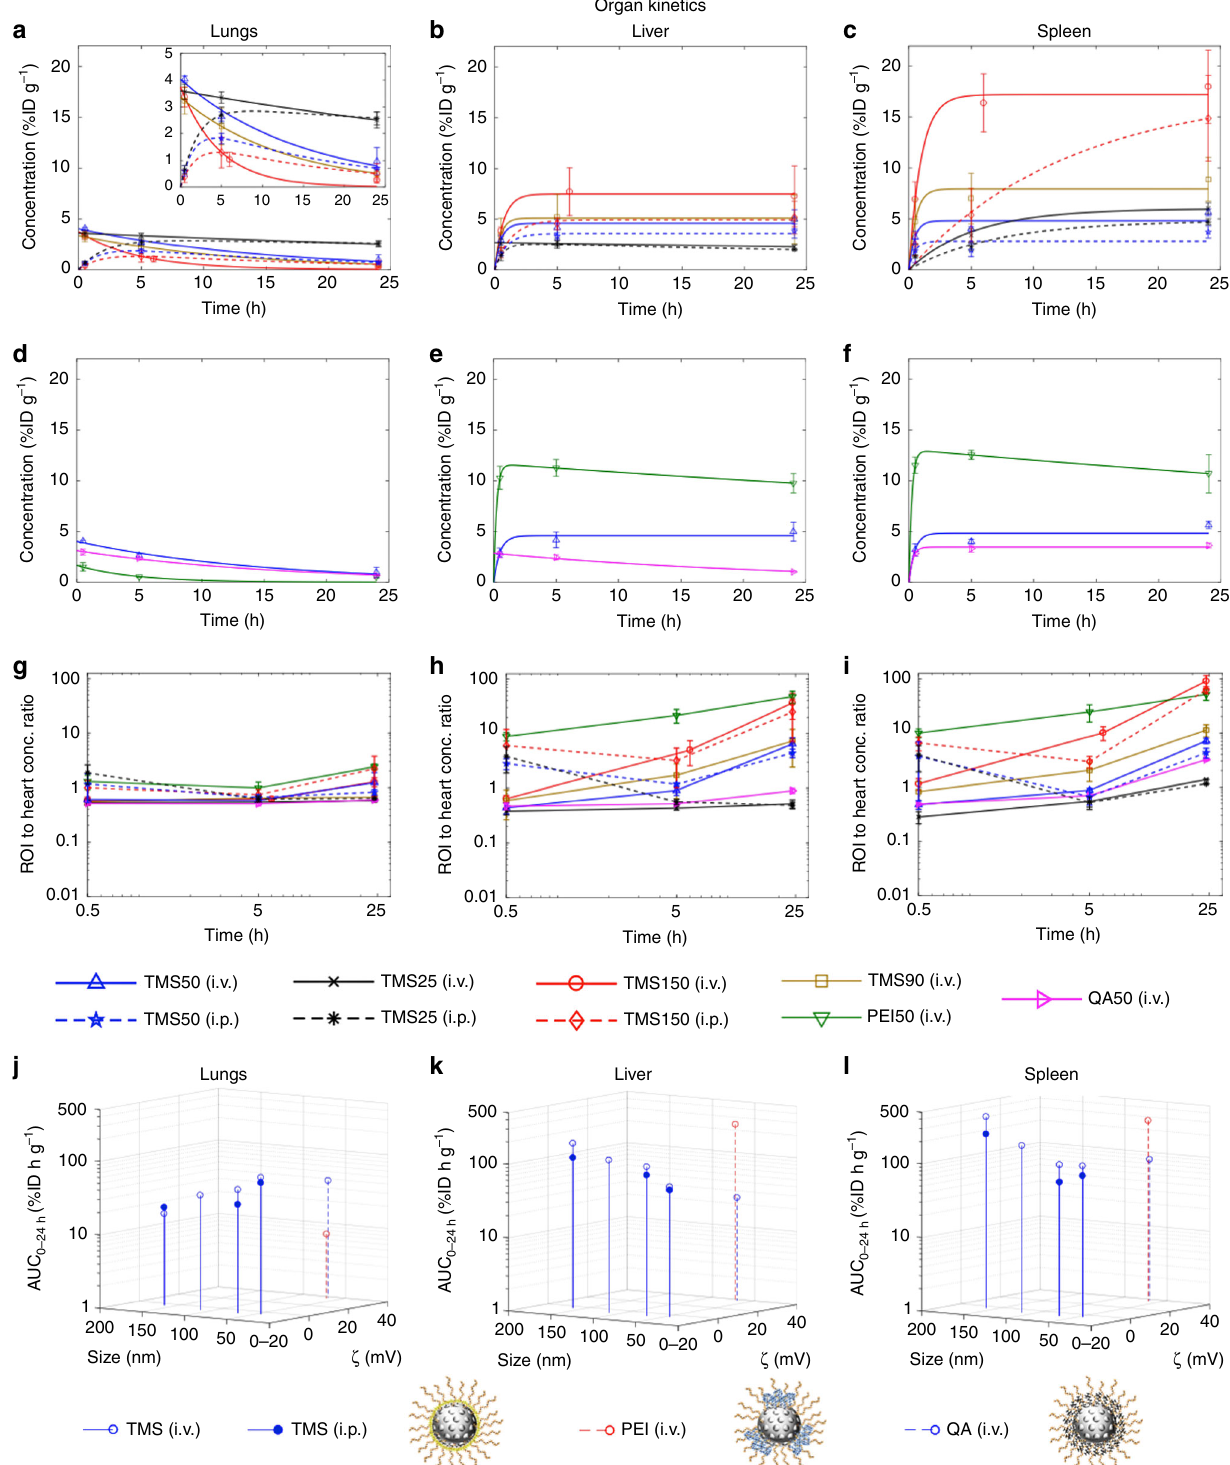
Fig. 5 Organ kinetics. Panel shows kinetic analysis for lungs, liver, and spleen. For analysis of the remaining ROIs refer to Supplementary Figs. 11 – 15. a – f For each ROI, non-linear regression of Eq. (4) or its adaptation was performed to the concentration – time data (Supplementary Tables 4 and 5). Fitted concentration – time curves demonstrate the effect of MSN size and route of administration for TMS-modi fi ed MSNs ( a – c ) and surface chemistry and zeta potential for 50 nm diameter MSNs modi fi ed with TMS, QA, or PEI ( d – f ). The inset in a is a rescaled version of the fi gure for a clearer view. Solid lines, i.v. cases; dotted lines, i.p. cases. g – i Observed concentration of ROIs normalized to concentration of heart (substitute for plasma) is shown over time on a log – log plot. j – l 3-D stem plots show area under the concentration – time curves (AUC 0 – 24h ), obtained for different MSNs from a – f , in multiparameter space. Data represent mean ± s.d., n = 4 (except TMS50 (i.p.) and TMS25 (i.p.), where n =